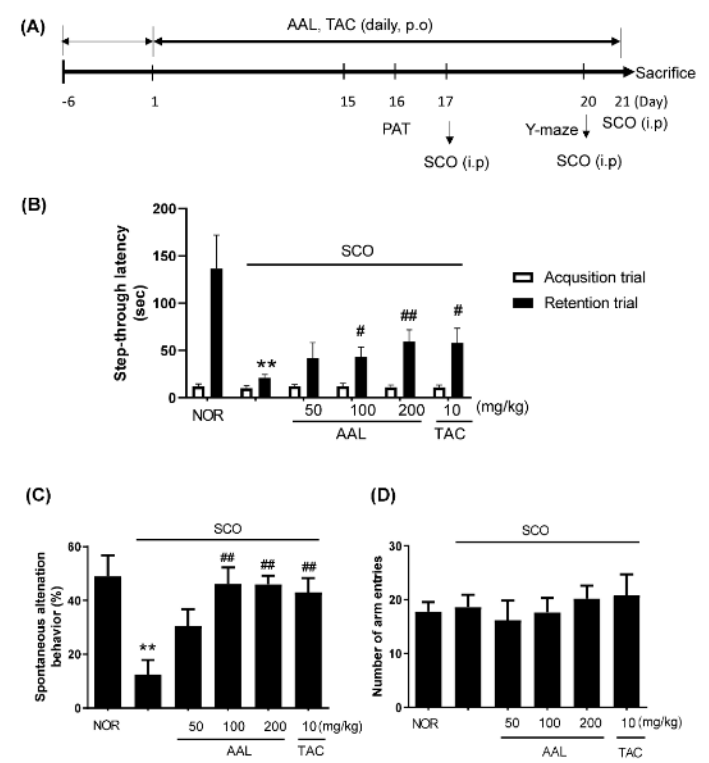
Figure 2. Effect of AAL extract on behavioral memory impairments in scopolamine-induced